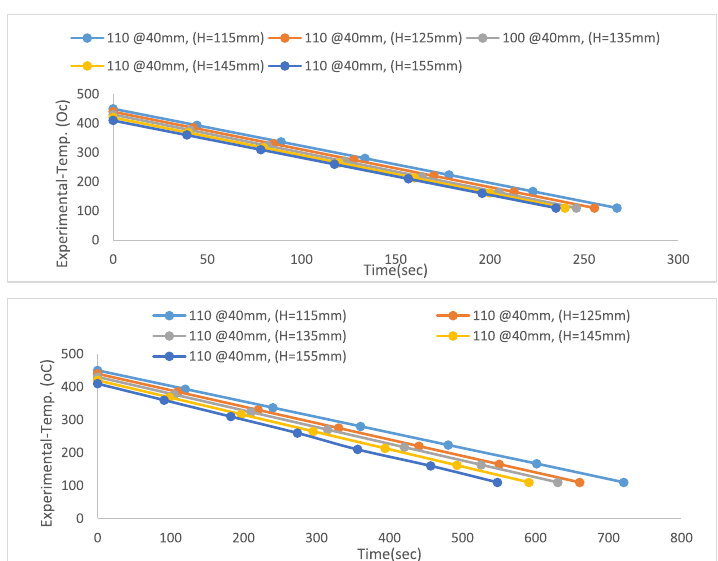
Fig. 7 Temperature time at 110 °C, D